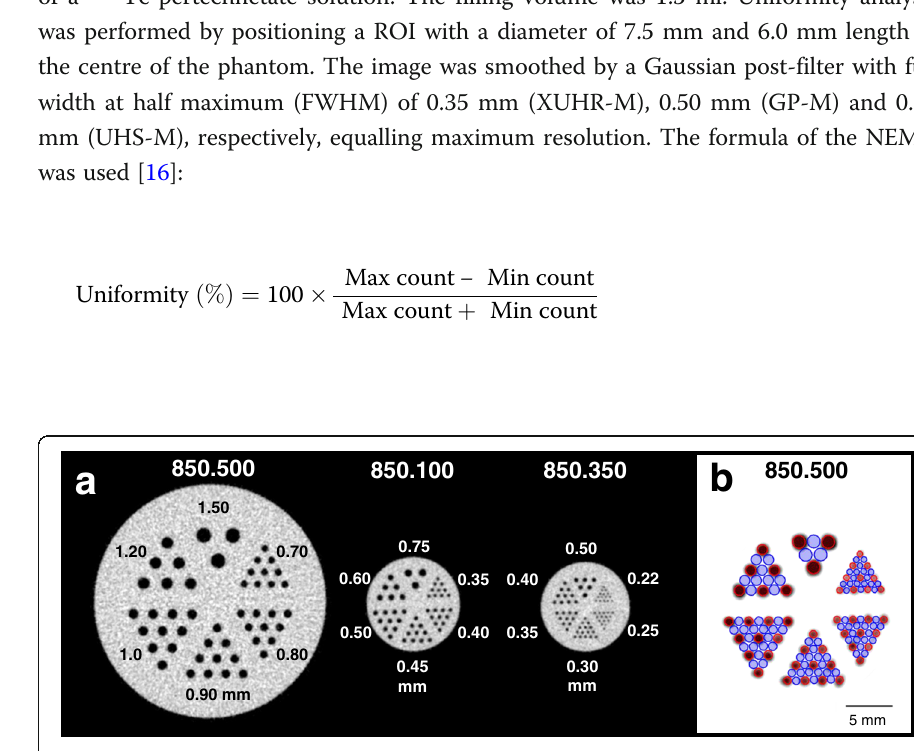
Fig. 2 a Axial view of tomographic CT images of the three mini Derenzo hot-rod phantoms with different ranges of rod diameters, here shown in mm. All three phantoms were employed for spatial resolution assessment. Phantom 850.500 and 850.100 were also used to create templates for the contrast-to-noise ratio (CNR) analysis. The templates consisting of hot and cold regions of interest (ROI) were placed on the SPECT images of the respective phantoms. Each ROI had a length of 6.0 mm and a diameter of 90% of the corresponding rod diameter. b SPECT image plus CNR template derived from a 45-min scan of the phantom 850.500 acquired with the GP-M collimator and an activity concentration of 30 MBq/ml. The slice thickness was set to 6.0